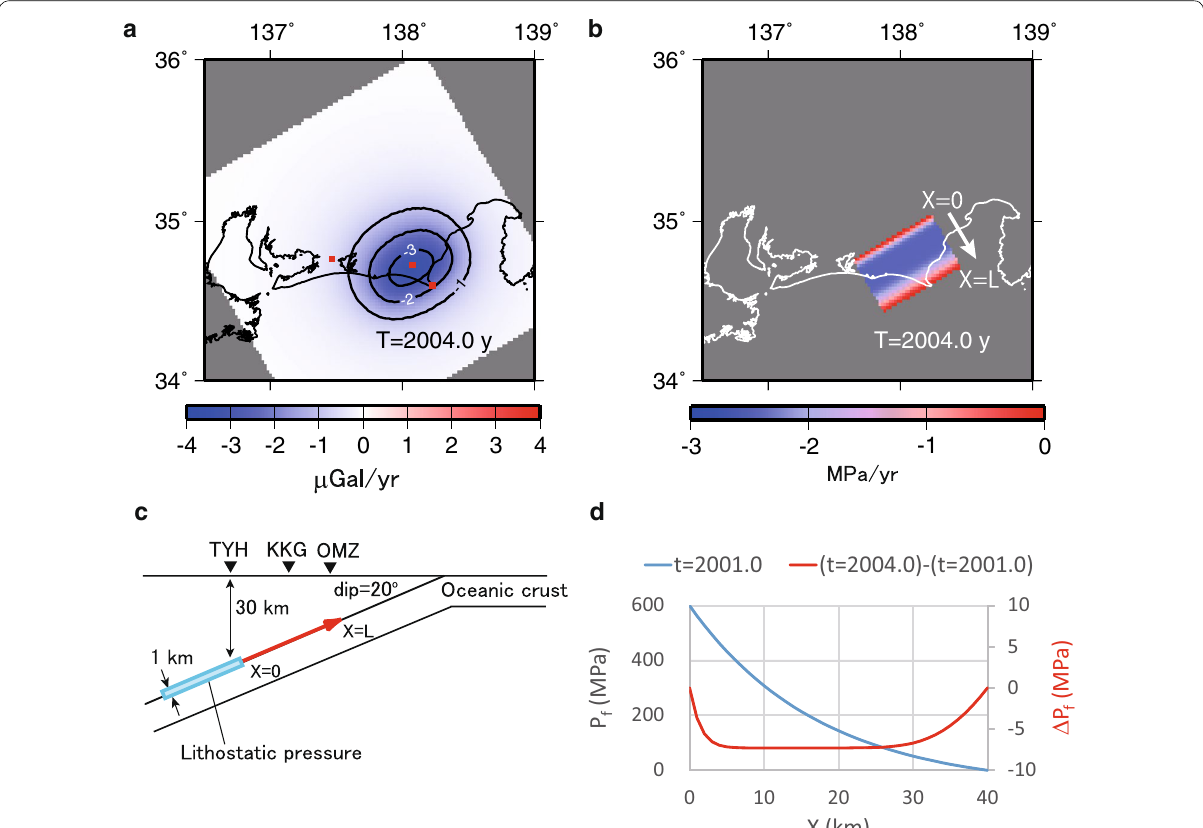
Fig. 4 The poroelastic model. a The rate for gravity change at 3 years after the onset of the LSSE for model B. b The same as in ( a ) but for the pres- sure increment. c A model configuration. The dip angle is assumed to be constant with depth. d The pressure increment along the X-axis for model B. The blue and red curves represent the steady-state solution (the left vertical axis) and the pressure change in 3 years from the onset of the LSSE (the right vertical axis),